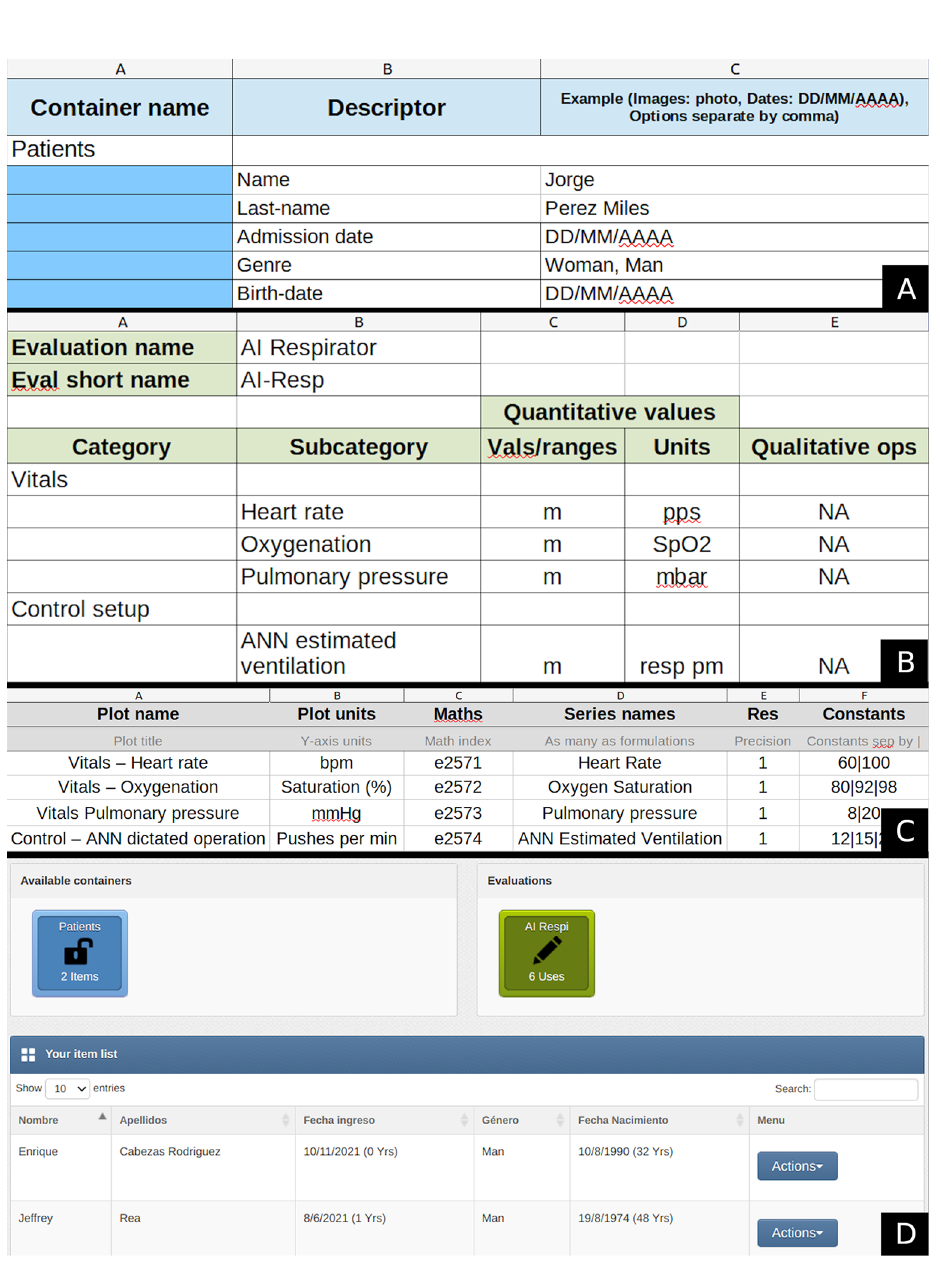
Figure 4. Evalu@ configuration. Panels A, B, and C show the configuration files used to create the containers, the tracking instruments, and the indexes ’ visualization, respectively. Panel D displays the main screen after setup